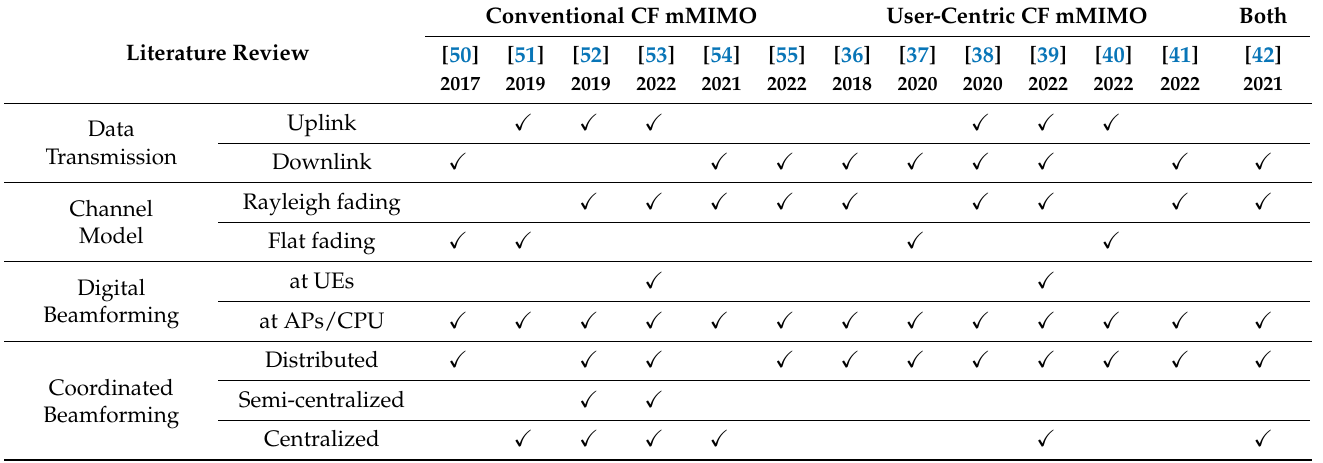
Table 2. A literature comparison for CF mMIMO systems under sub-6 GHz frequency